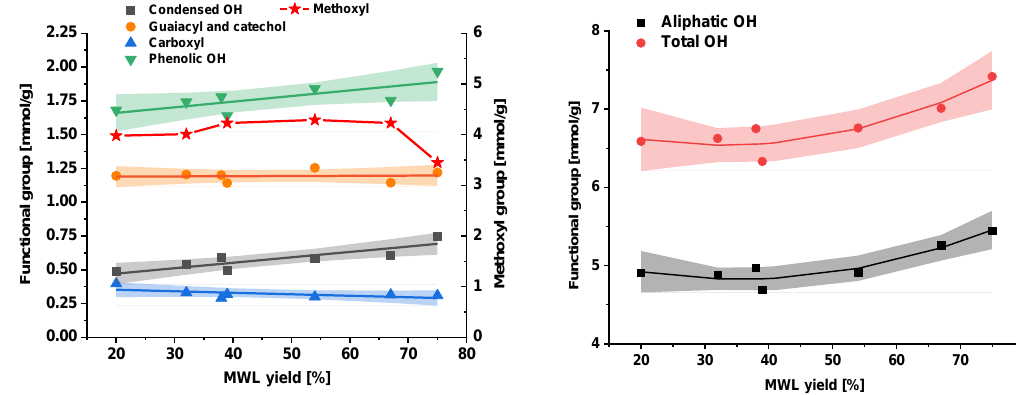
Figure 4. Functional groups of crude MWL depending on the milling yield. Shadowed areas indicate the 95% confidence interval.